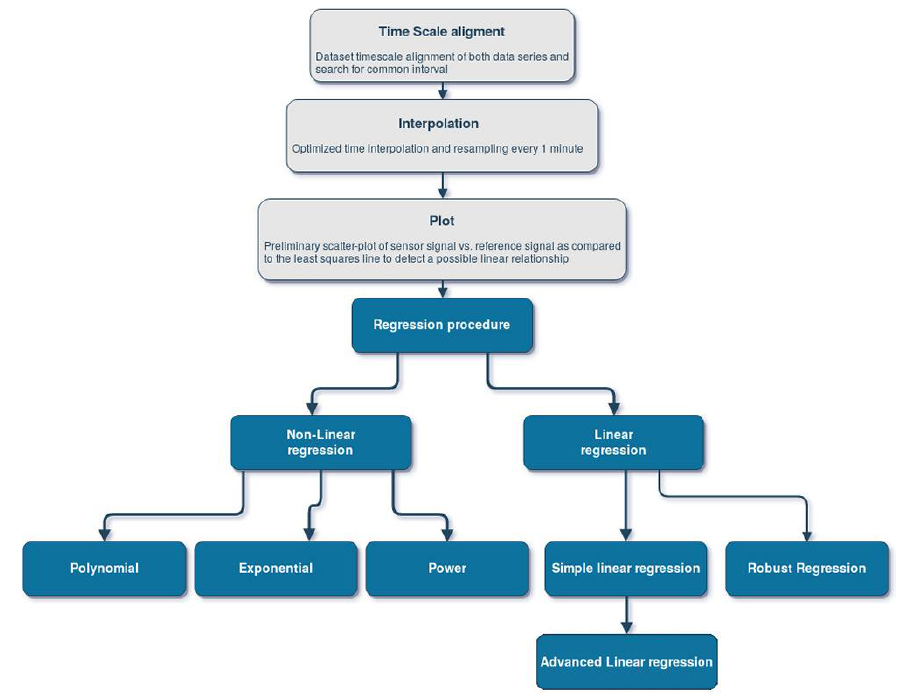
Figure 4. Workflow of the developed calibration procedure.